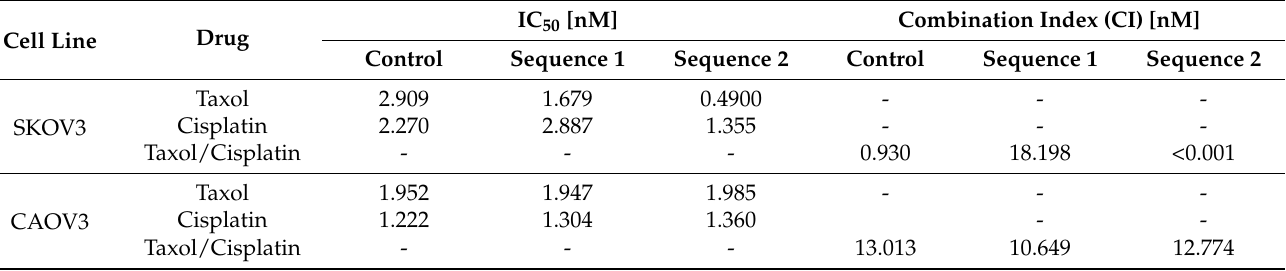
Table 1. IC50 for Taxol and cisplatin, and combination index (CI) for the combination of both drugs in SKOV3 and CAOV3 cells. CI < 1 indicates synergistic effect, CI = 1 indicates additive effects and CI > 1 indicates antagonistic